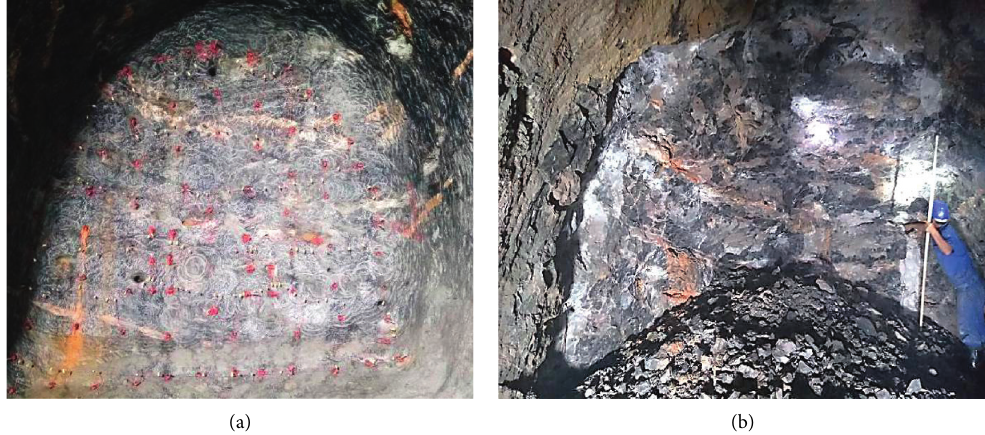
Figure 13: The explosive quality and blasting effect of Test 2: (a) explosive charge and (b) after